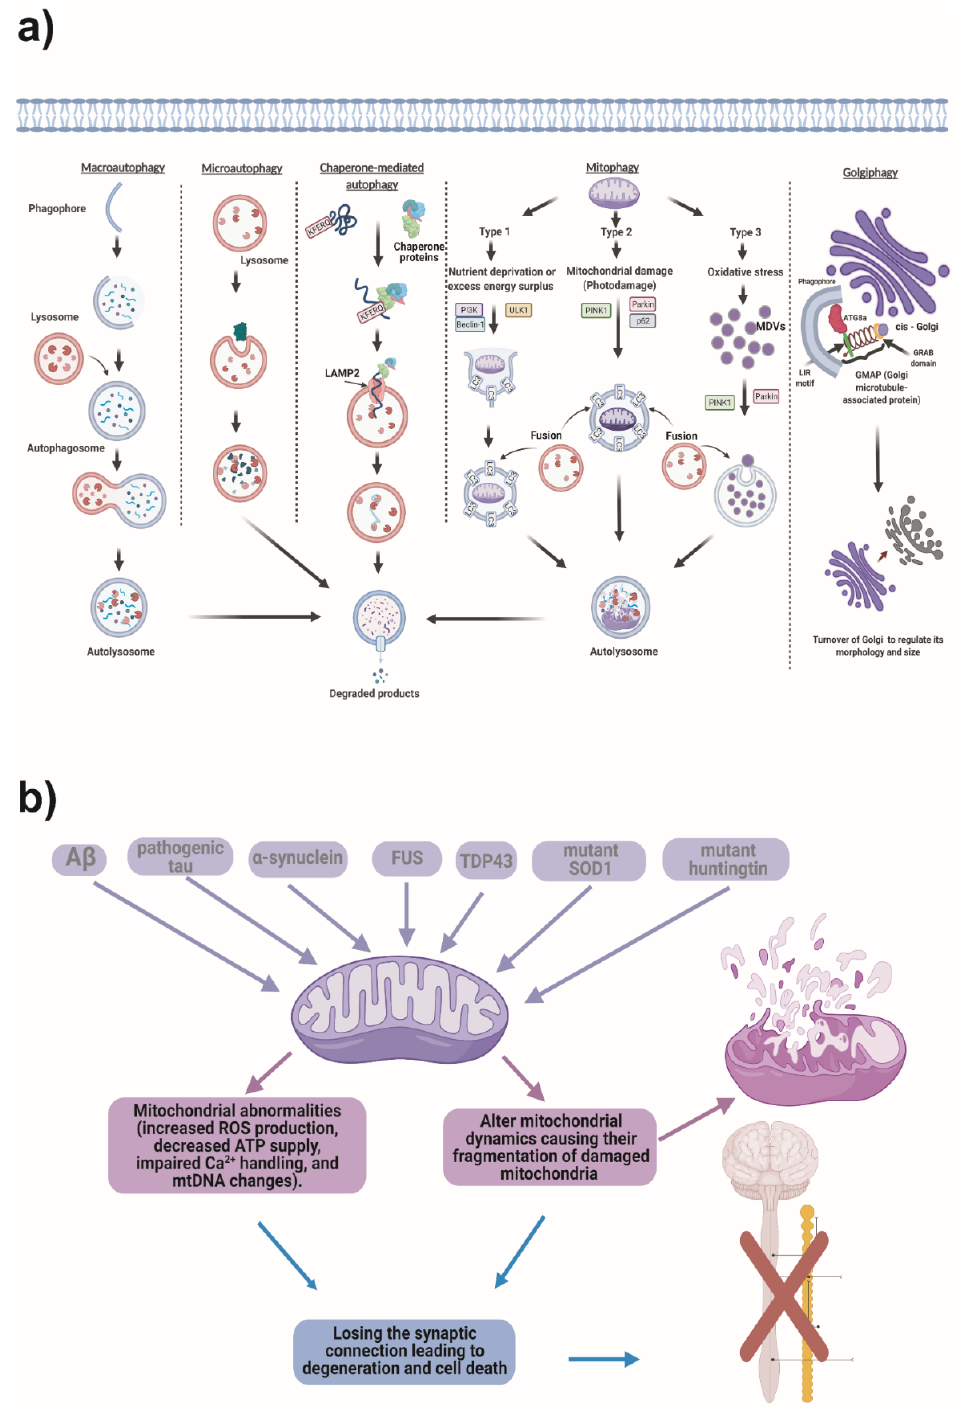
Figure 1. Autophagy types and mitochondrial stress. ( a ) Autophagy types: schematic representation of macroautophagy, microautophagy, chaperone-mediated autophagy, mitophagy, and golgiphagy. ( b ) Many factors can generate mitochondrial stress (A β , pathogenic tau, α -synuclein, FUS, TDP-43, mutant SOD1, and mutant huntingtin). The consequences are mitochondrial abnormalities and altered mitochondrial dynamics that lead to degeneration and cell death.“Created with BioRender.com (accessed on 1 May